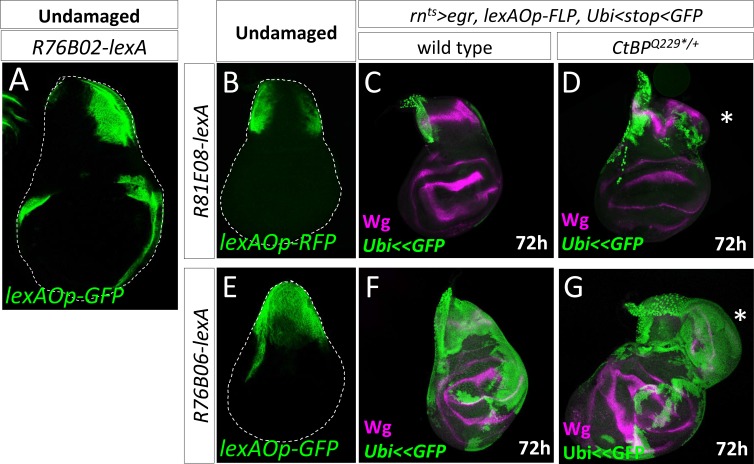
Lineage tracing of cells from specific regions of the notum using lexA lines.(A) Undamaged wing disc with R76B02-lexA driving the expression of lexAOp-GFP. (B–D) Wing discs with R81E08-lexA driver in undamaged disc (B) with lexAOp-RFP (shown in green) and following rnts>egr induced damage with lineage tracing in wild type (C) and CtBPQ229*/+ (D) genetic backgrounds. (E–G) Wing discs with R76B06-lexA driver in undamaged disc (E) with lexAOp-GFP and following rnts>egr induced damage with lineage tracing in wild type (F) and CtBPQ229*/+ (G) genetic backgrounds. Ectopic wing pouches are indicated with an asterisk (*). Lineage tracing is with lexAOp-FLP, Ubi<stop<GFPnls and the damaged discs are shown after 72 hr of recovery and stained with anti-Wg (magenta).